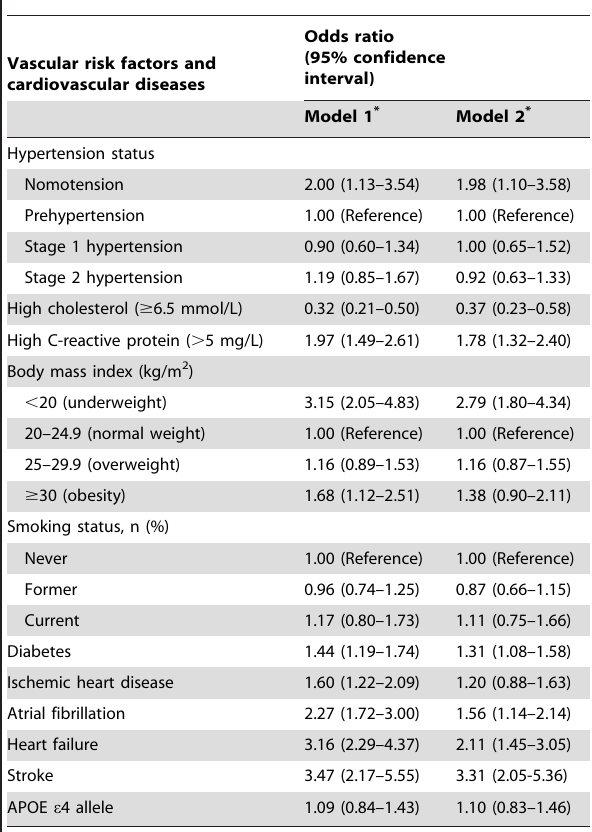
Table 2 . Odds ratios (95% confidence interval) of mobility limitation associated with cardiovascular risk factors and vascular diseases (n= 2725).